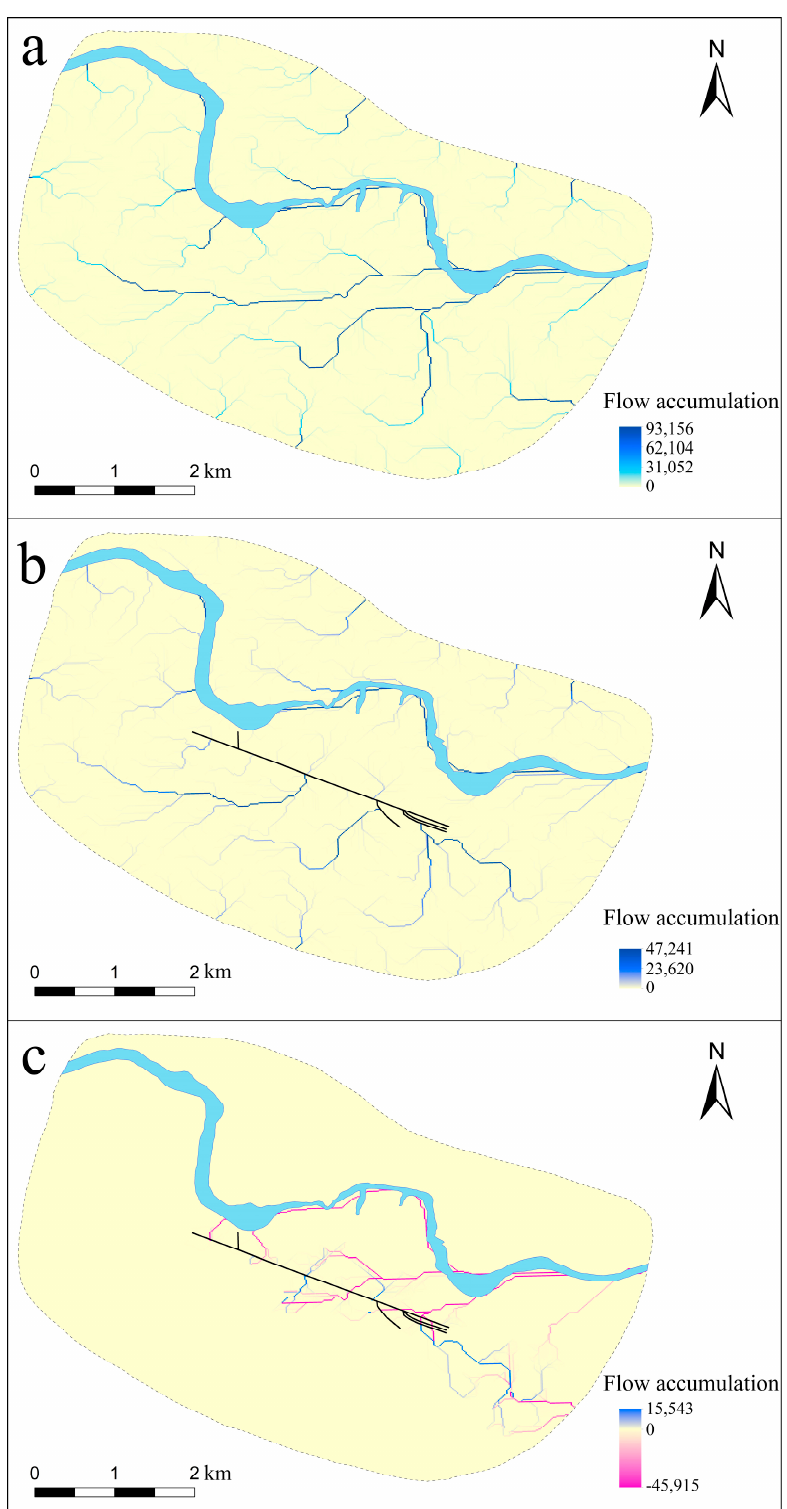
Figure 4. ( a ) Flow accumulation before channel construction at Yinxu; ( b ) flow accumulation after channel construction at Yinxu; ( c ) change in flow accumulation before and after channel construction at